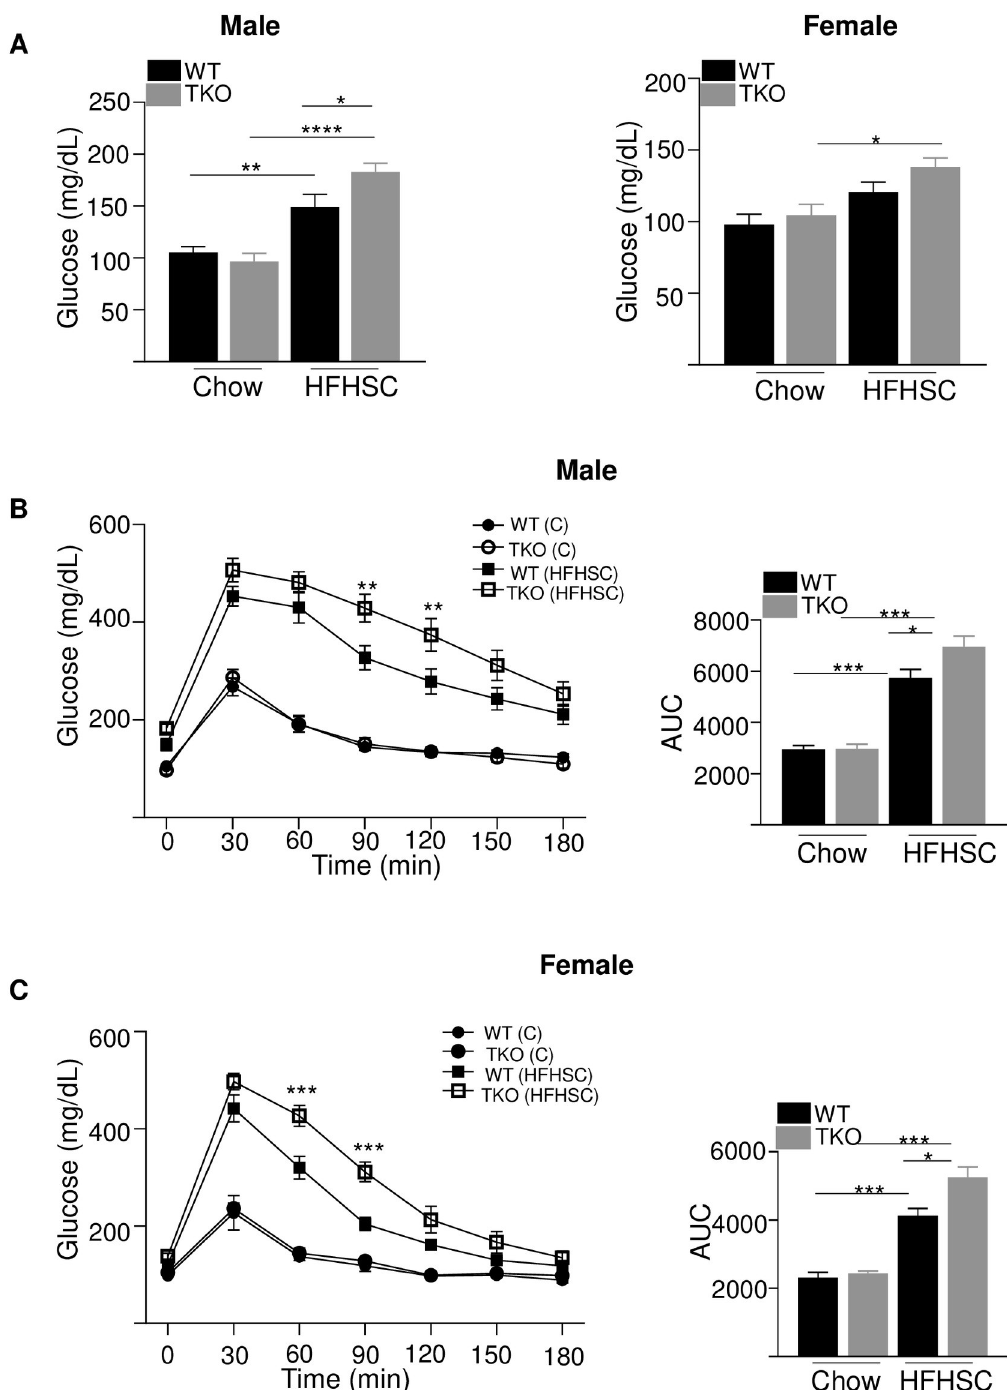
Fig 4. Loss of SAA has a significant but modest effect on diet-induced glucose tolerance. A) Basal glucose levels in male and female WT and TKO mice after 12 weeks of chow and HFHSC diet feeding (n = 5–15). Data are mean ± SEM; � = P � 0.05; �� = P � 0.01 and ��� = p � 0.001. B) intraperitoneal glucose tolerance test (IPGTT) was performed in male mice after 12 weeks of chow and HFHSC diet feeding (n = 10/group). The area under the curve (AUC) is shown in the right panel. Data are mean ± SEM; �� = P � 0.01 between WT HFHSC and TKO HFHSC group of mice. � = P � 0.05 and ��� = P � 0.001. C) IPGTT was performed in female mice after 12 weeks of chow and HFHSC diet feeding (n = 5-15/group). The area under the curve (AUC) is shown in the right panel. Data are mean ± SEM; ��� = P � 0.001 between WT HFHSC and TKO HFHSC group of mice. � = P � 0.05 and �� = P � 0.01.